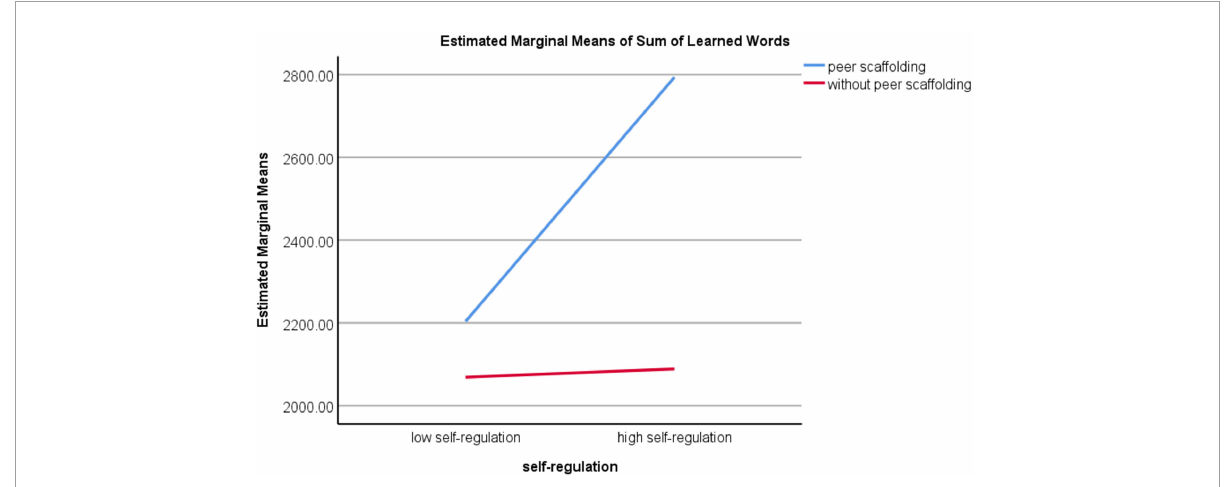
FIGURE3 The interaction effect of self-regulation and peer scaffolding on the sum of learned